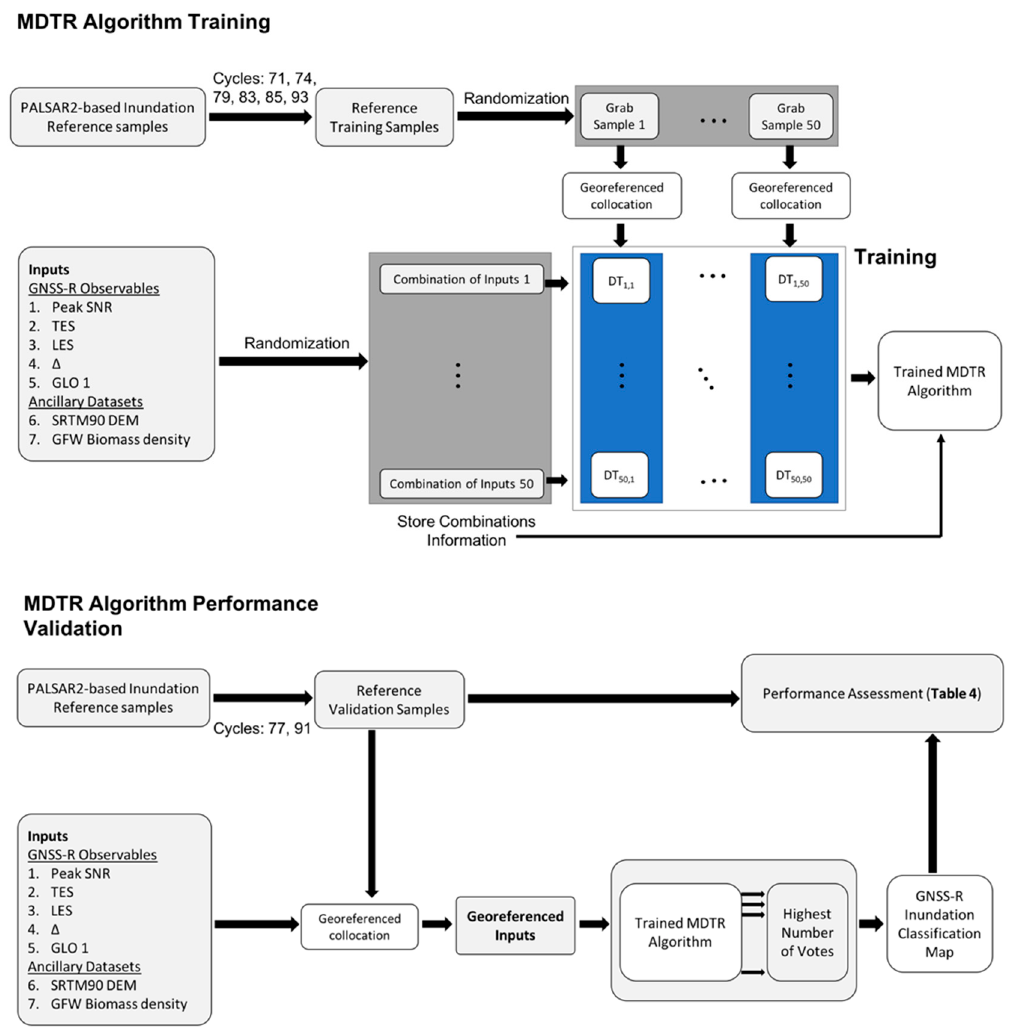
Figure 7. Flowchart showing the MDTR construct to obtain the GNSS-R inundation classification. The top shows the internal structure and training of the MDTR algorithm. The MDTR algorithm trains on 50 grab samples, selected randomly from the reference training samples (cycles 71, 74, 79, 83, 85, and 93 of the PALSAR-2-based inundation reference maps), and 50 combinations of inputs, selected randomly from all possible combination of inputs, creating 2500 decision trees (DT) using a standard classification and regression tree (CART) for machine learning described by [54] for each one of the DT. In the bottom, the validation reference samples (cycles 77 and 91 of the PALSAR-2-based inundation reference maps) are used to obtain the corresponding CYGNSS geolocated observables. Those georeferenced observables are input into the MDTR algorithm. A total of 2500 outputs are evaluated, and the answer with the highest number of votes is selected for each grid cell in order to build the final GNSS-R inundation classification map. This output is then compared to the PALSAR-2 validation reference samples to assess the performance of the GNSS-R inundation classification obtained from the MDTR